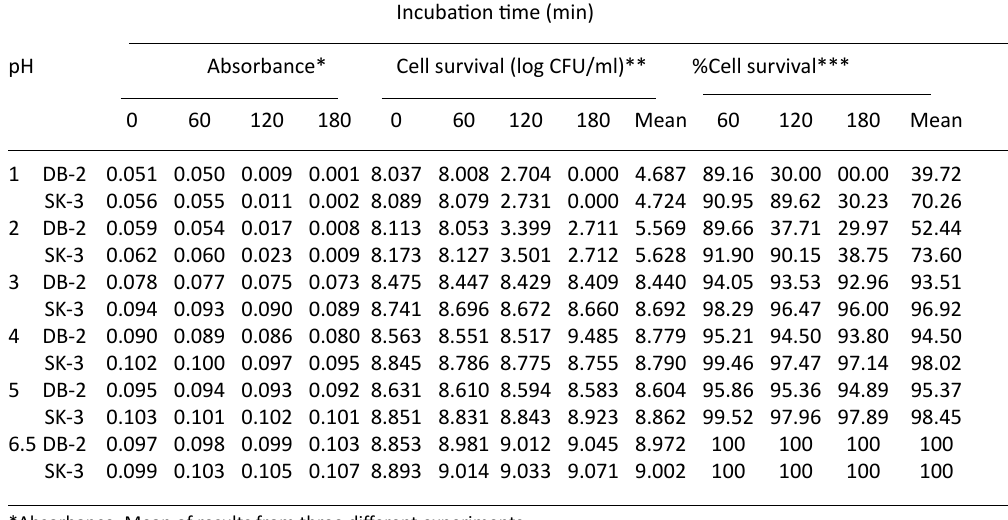
Table 3. Acid tolerance of L. plantarum DB-2 &